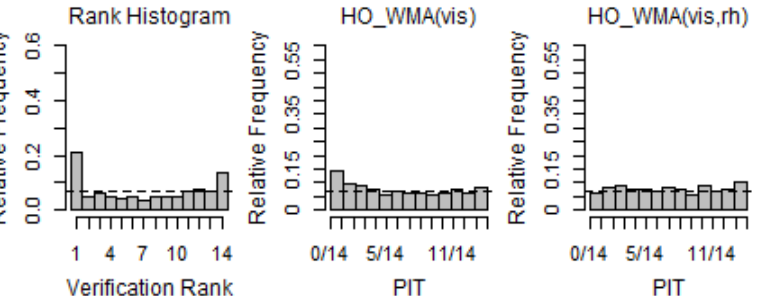
Figure 5. Verification rank histogram of raw ensemble forecasts and PIT histograms of WMA models for Station 113 (2018–2019 DJF).